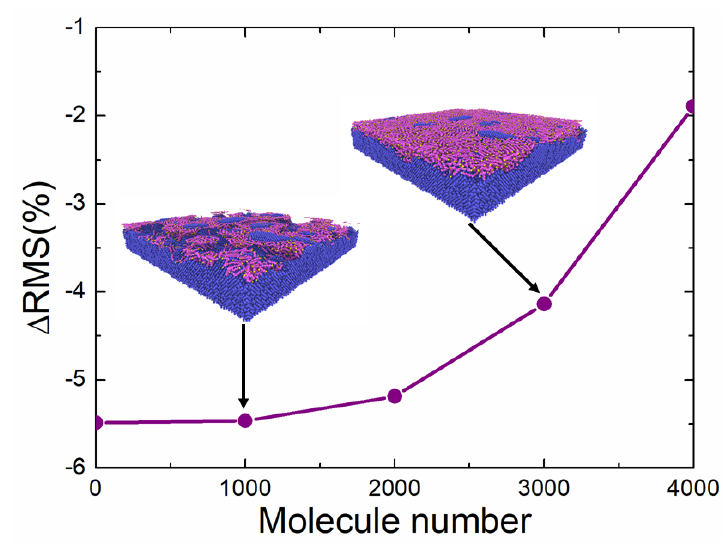
Figure 4. ( a ) RMS change ∆RMS and contact area A/A0 of dry contact as a function of pressure. The circle, square and triangle indicate RMS=0.2, 0.5 and 0.8 nm, respectively. Changes in the topography before ( a ) and after ( c ) loading for the surfaces with RMS=0.2, 0.5 and 0.8 nm, respectively.